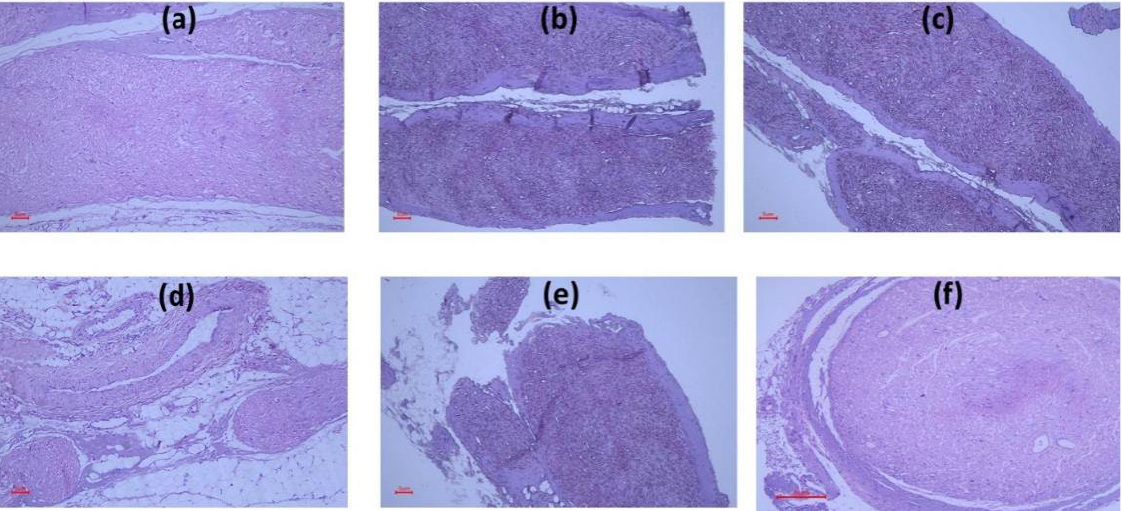
Figure 8. Effect of isoeugenol, eugenol, and their combination on histology of sciatic nerve. ( a ) Normal control, ( b ) diabetic control, ( c ) STZ + pregabalin, ( d ) STZ + isoeugenol, ( e ) STZ + eugenol, and ( f ) STZ + isoeugenol + eugenol.